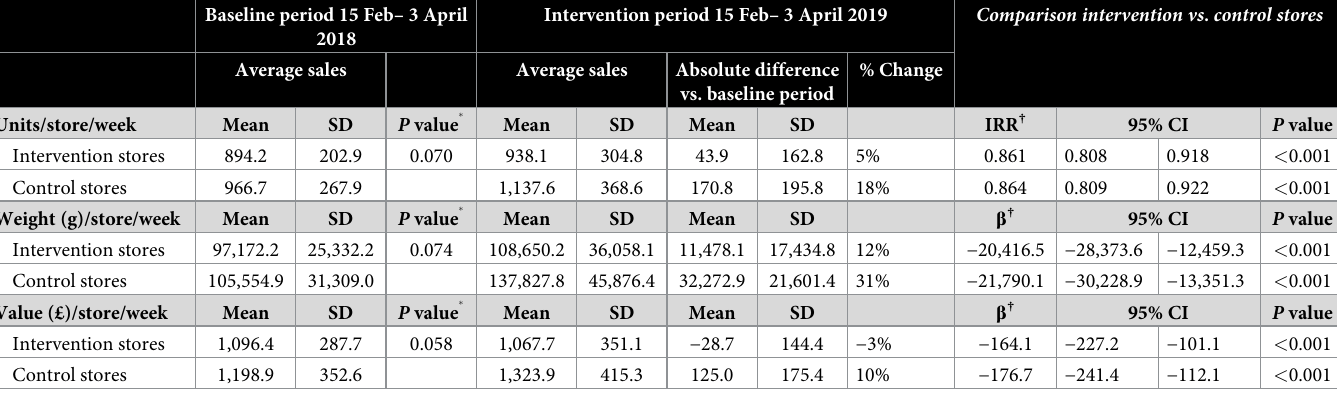
Table 2. Average weekly sales of confectionery in intervention vs. control stores and comparison of changes before/after intervention between intervention vs. con- trol